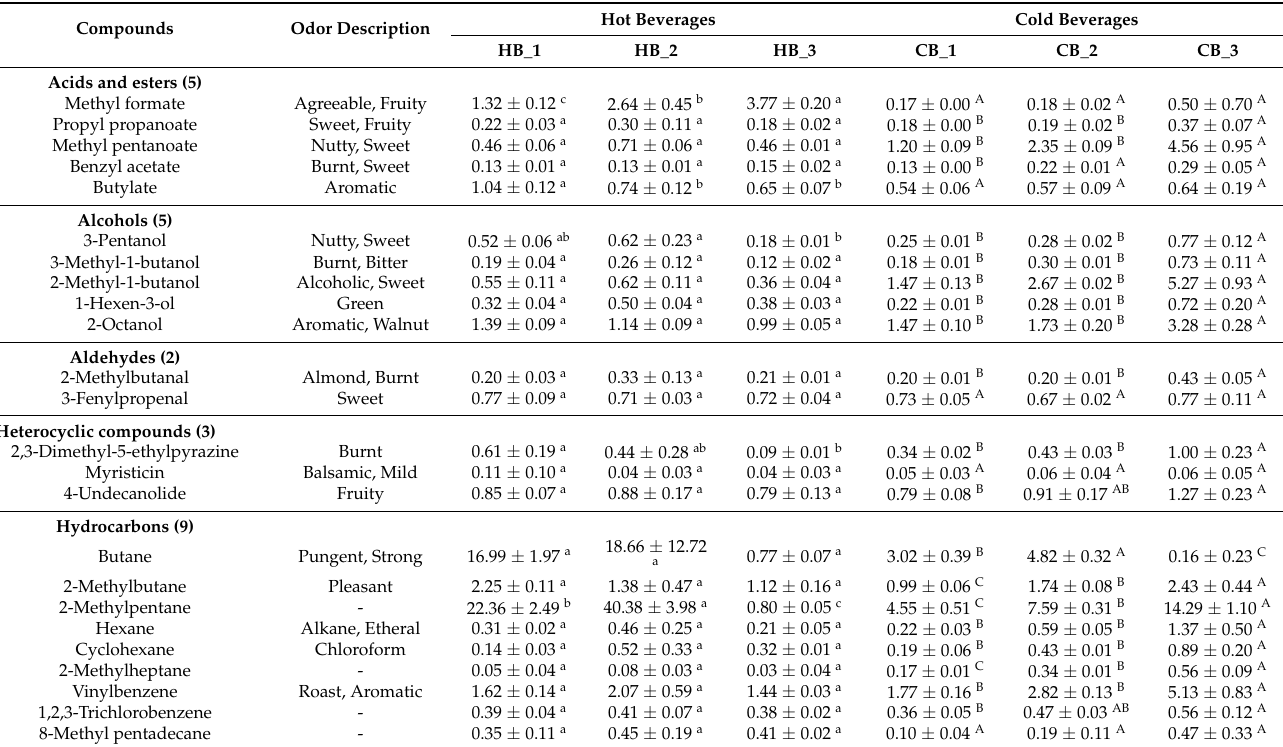
Table 2. Volatile profile of roasted germinated wheat beverages by E-nose (Peak area × 10 3 ).